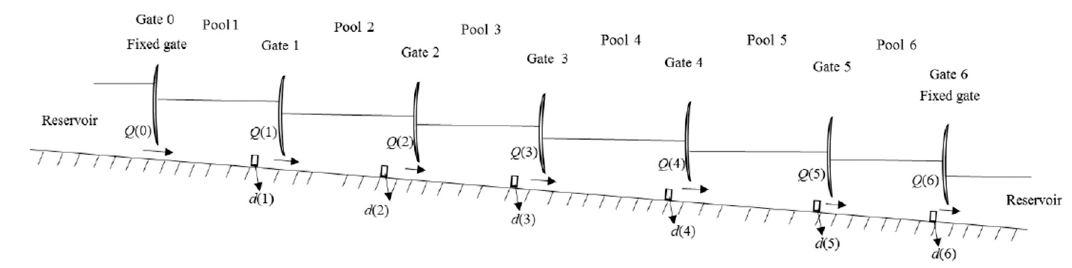
Figure 18. Layout of the studied canal system [24].